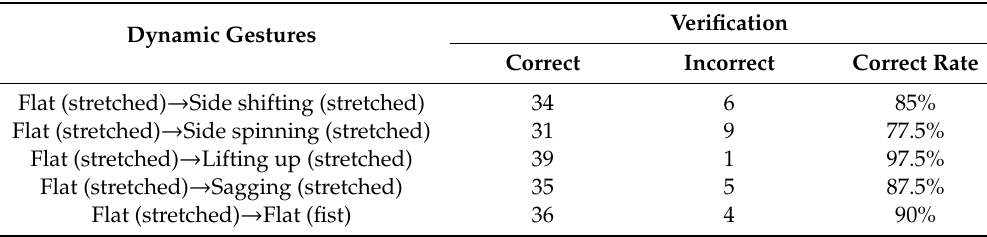
Table 4. Dynamic gesture